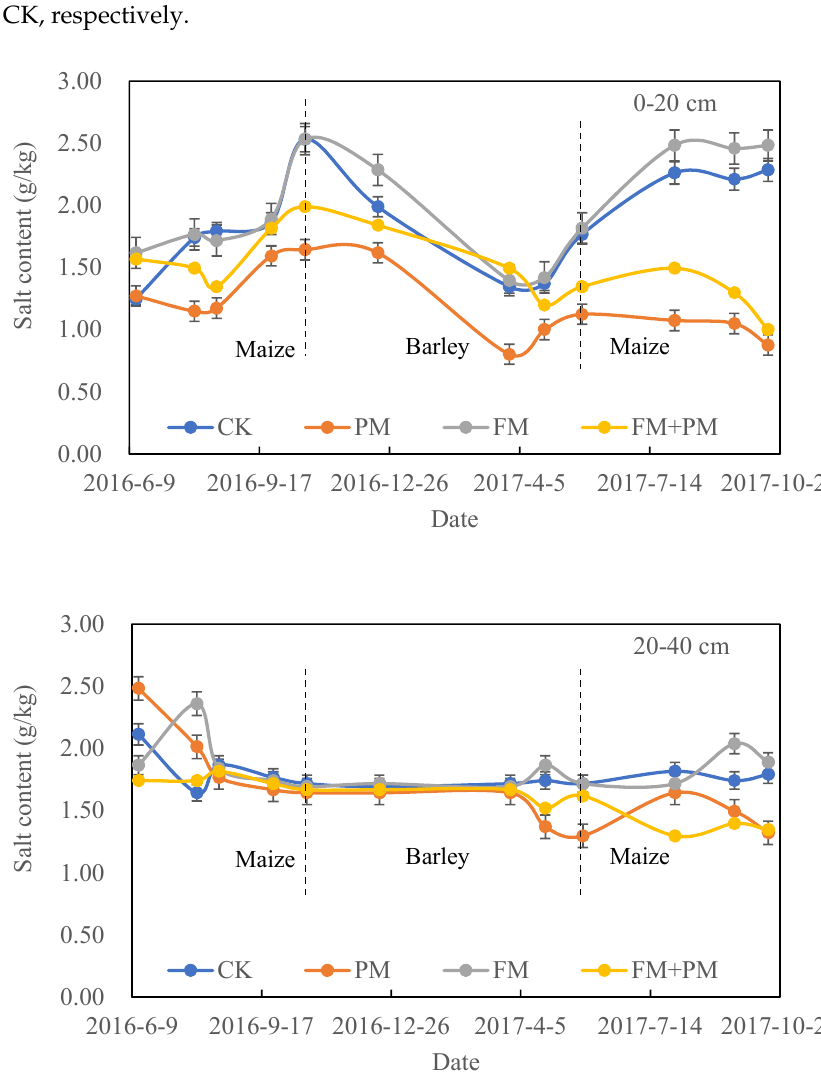
Figure 3. Soil salt content in the 0–20 cm and 20–40 cm soil layers under CK, PM, FM, and PM+FM treatments during the experimental period. CK: control treatment, PM: plastic film mulch, FM: farmyard manure, PM+FM: plastic film mulch combined with farmyard manure. The vertical bars represent the standard deviations of the data.